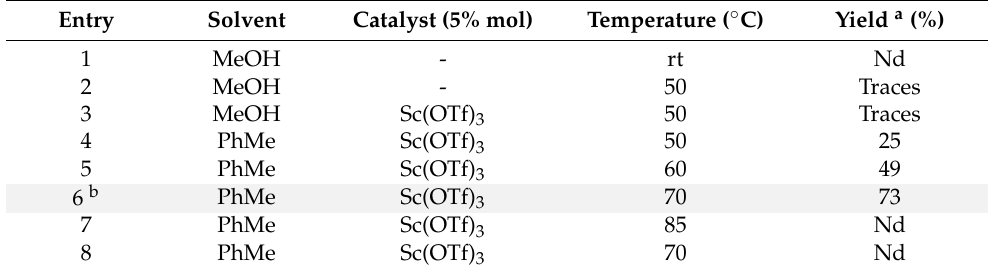
Table 1. Synthesis of the product 1.